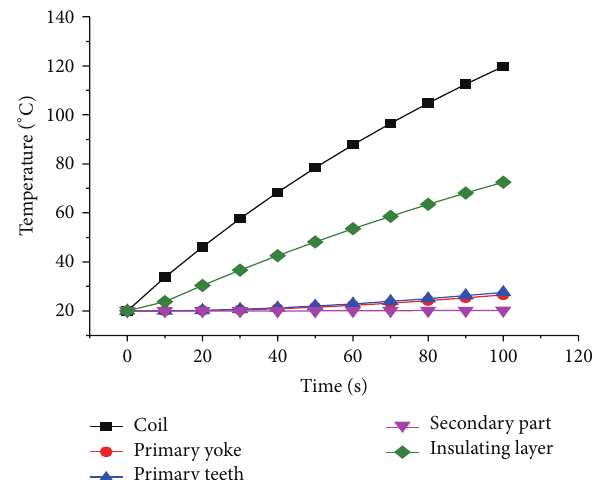
Figure 10: The temperature rising curve of the new secondary structure TPMLWG in three-phase short